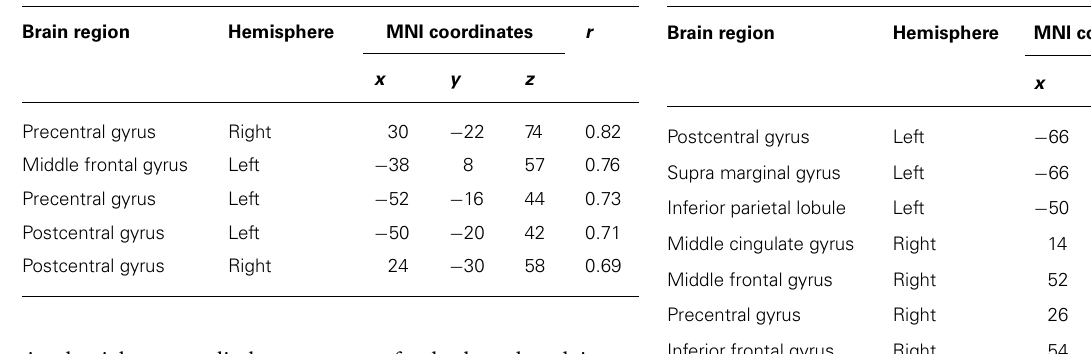
imaginary coherence with the left M1 during real and imagined movements were calculated over the whole brain. Brain regions with significant correlations are represented in orange ( p < 0.05, FDR-corrected).